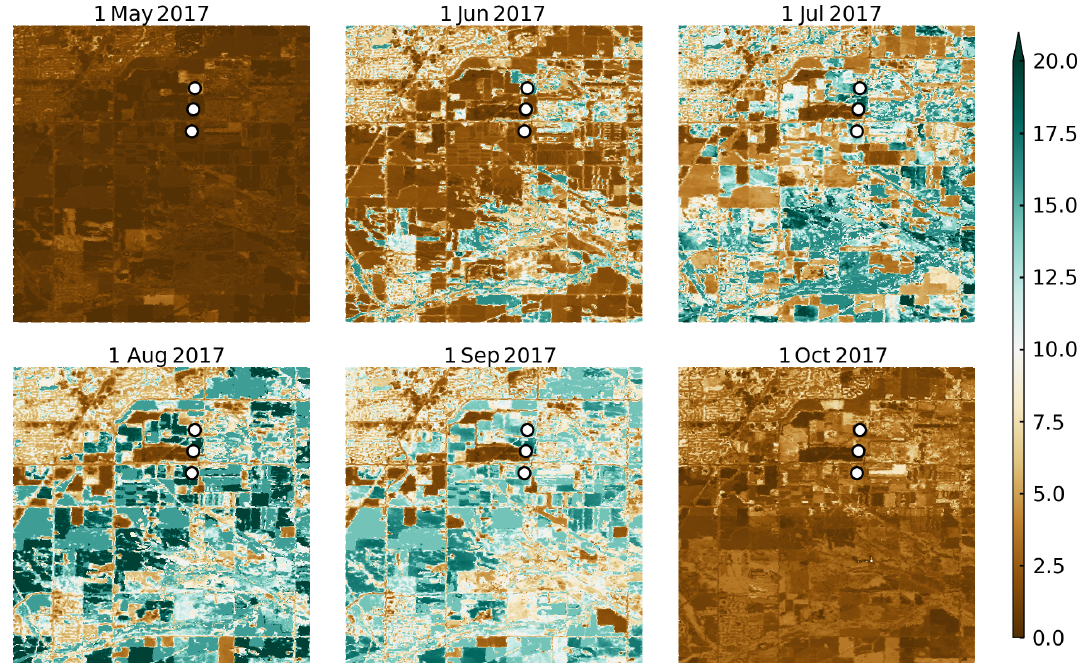
Figure A4. Examples of daily GPP (gCm − 2 d − 1 ) derived from BESS-STAIR at Rosemount (44.65–44.75 ◦ N, 93.05–93.15 ◦ W) in 2017. Circles indicate flux towers in this